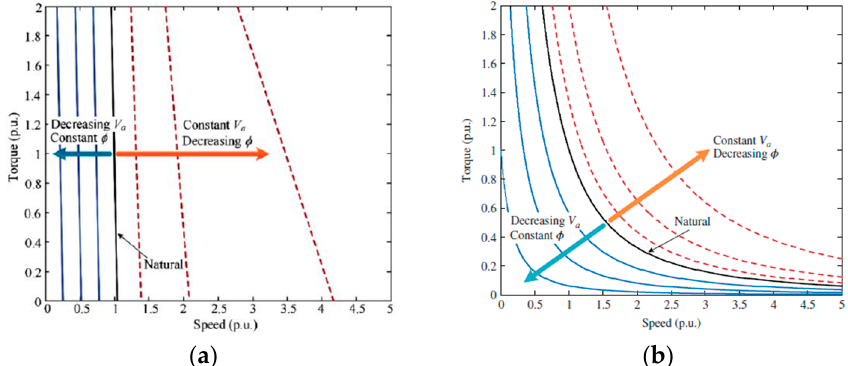
Figure 7. ( a ) Characteristics of separately excited DC motor control, ( b ) characteristics of series DC motor control.